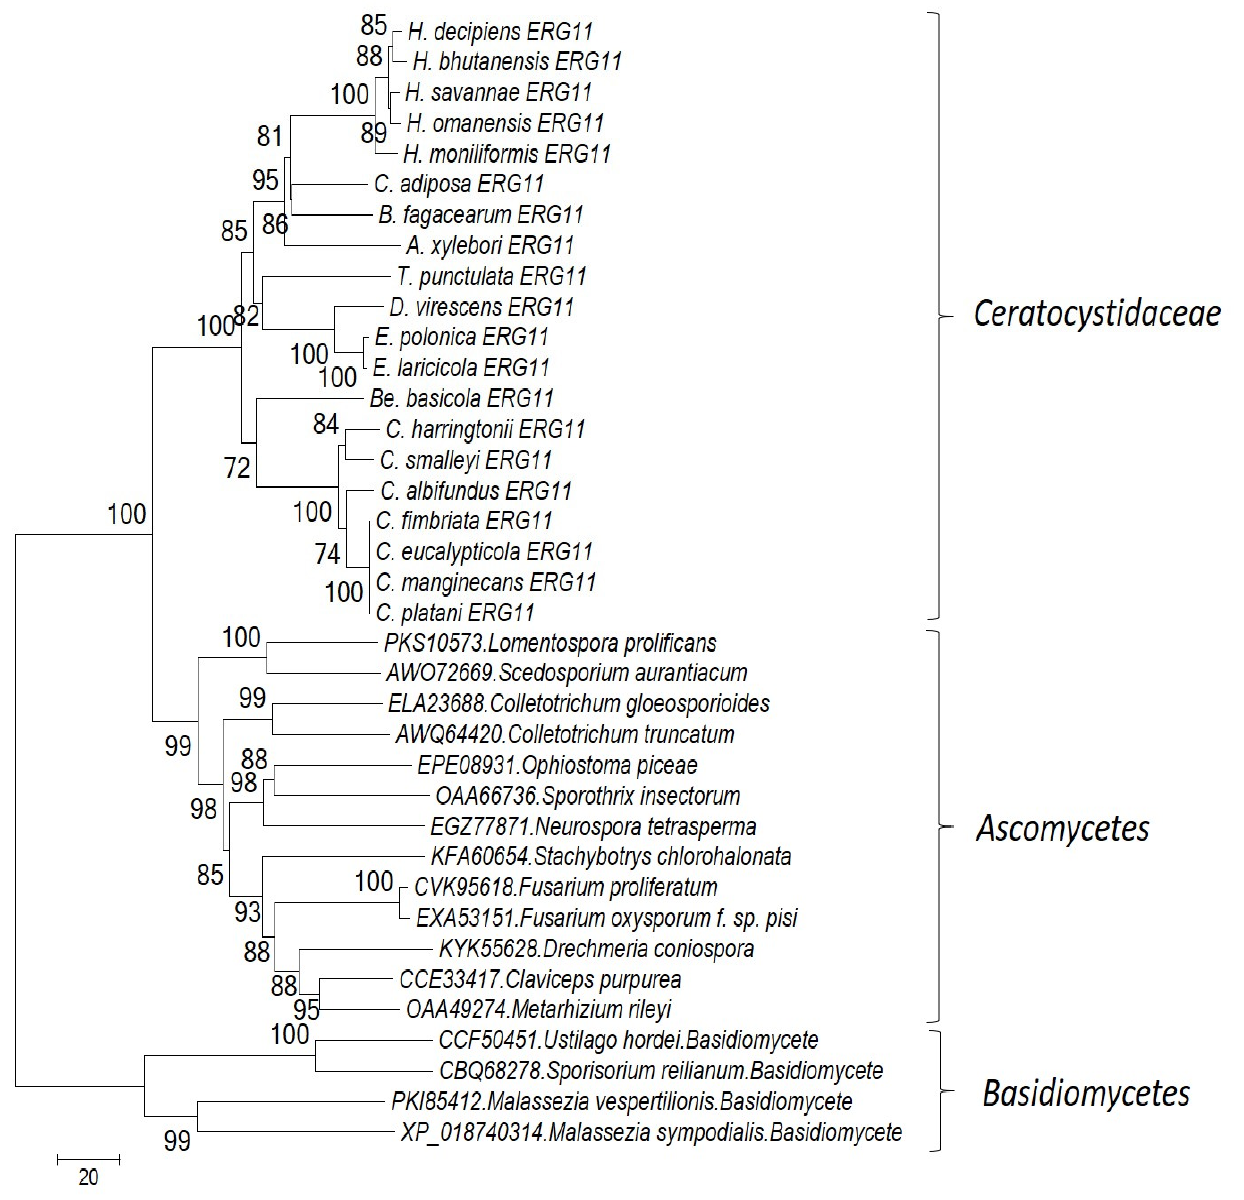
Figure 3. A maximum-likelihood tree of ERG11 protein sequences from different members of Ceratocystidaceae (one or more species of the following genera: Ceratocystis , Huntiella , Thielaviopsis , Bretziella , Endoconidiophora , Ambrosiella , Dadidsoniella and Berkeleyomyces ), was achieved using the MEGA7 software and substitution model LG+I+G+F. The ERG11 from Ceratocystidaceae is shown with an underline. The evolutionary distances are in the units of the number of amino acid differences per sequence. The analysis involved 31 amino acid sequences. All positions with less than 95% site coverage were